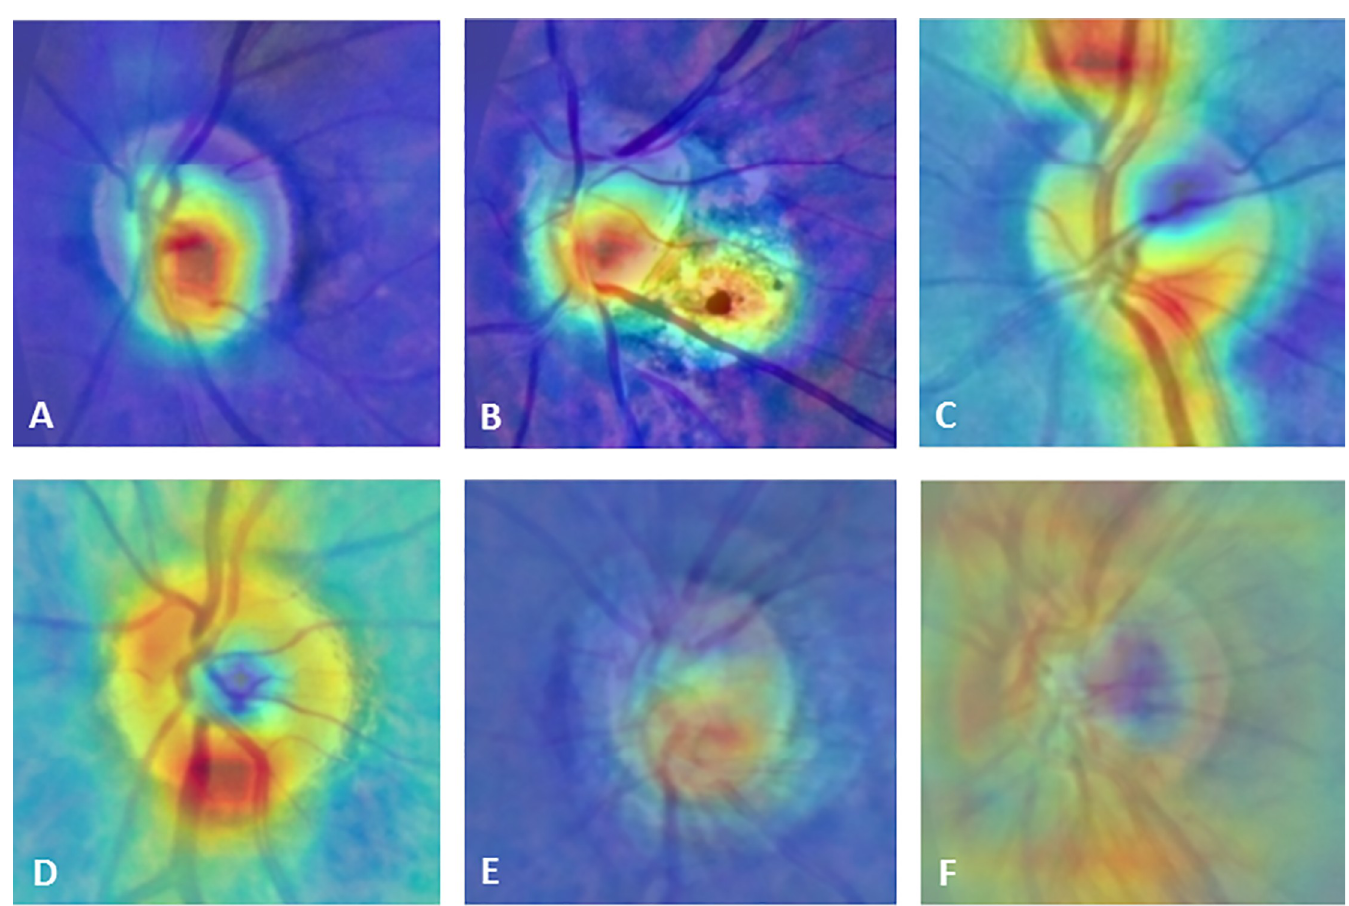
Fig 7. Representative CAMs and superimposed images showing different patterns between the glaucomatous and healthy eyes. The hot spots (red color) were localized at the cup and the region of parapapillary atrophy in the glaucomatous eyes (A, B), and at the neuroretinal rim or along the nerve fibers bundles in the healthy eyes (C, D). The superimposed images with CAM centered at the disc, showed the different patterns of CAM between the glaucomatous (E) and healthy eyes (F). CAM, class activation maps.